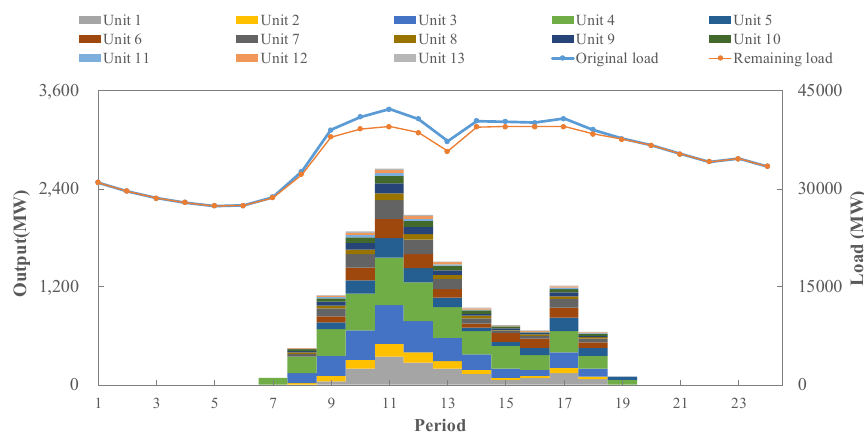
Figure 5. Scheduling results of the MILP model in Case 1. Table 4. Operation statuses of all the gas-fired generating units in Case